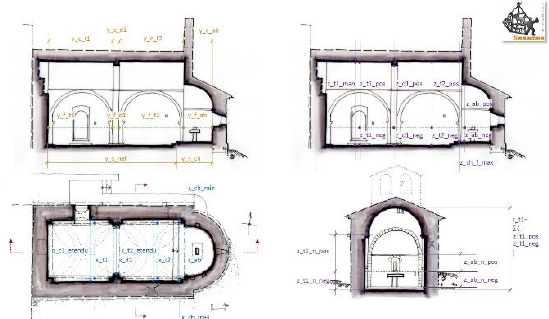
Figure 11 : An illustration of some of the predefined “significant dimensions” the values of which can be extracted using the 3D